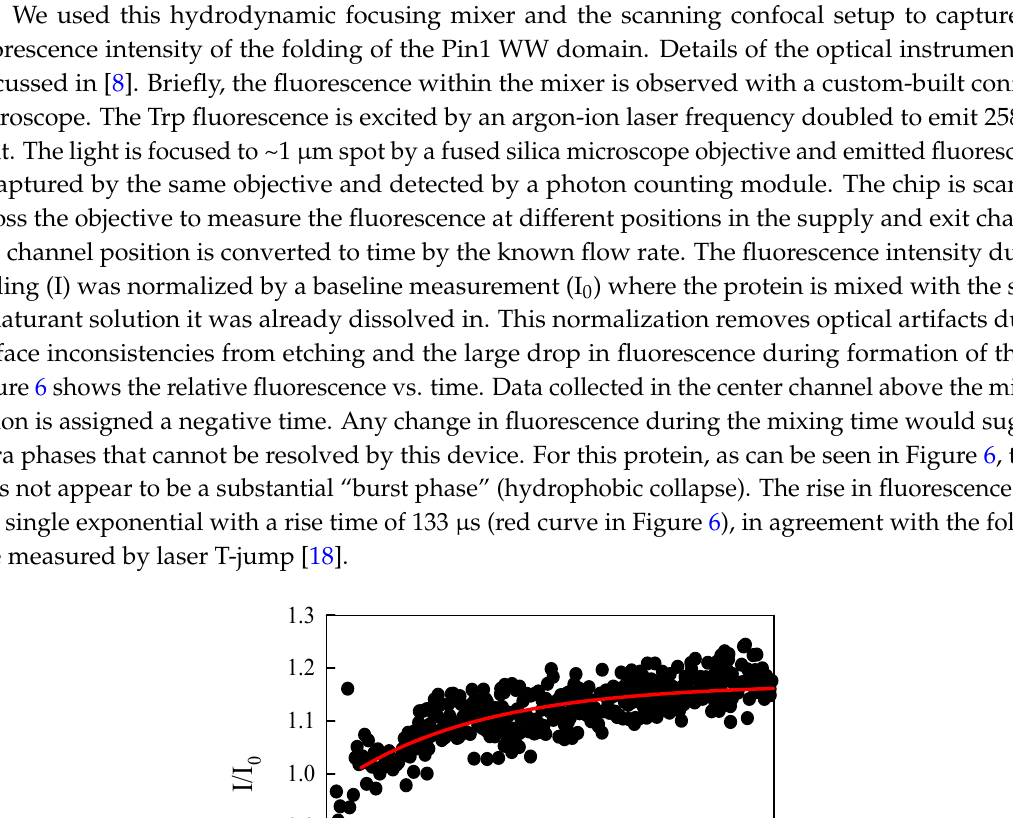
Figure 6. Relative fluorescence of the refolding experiment versus time.